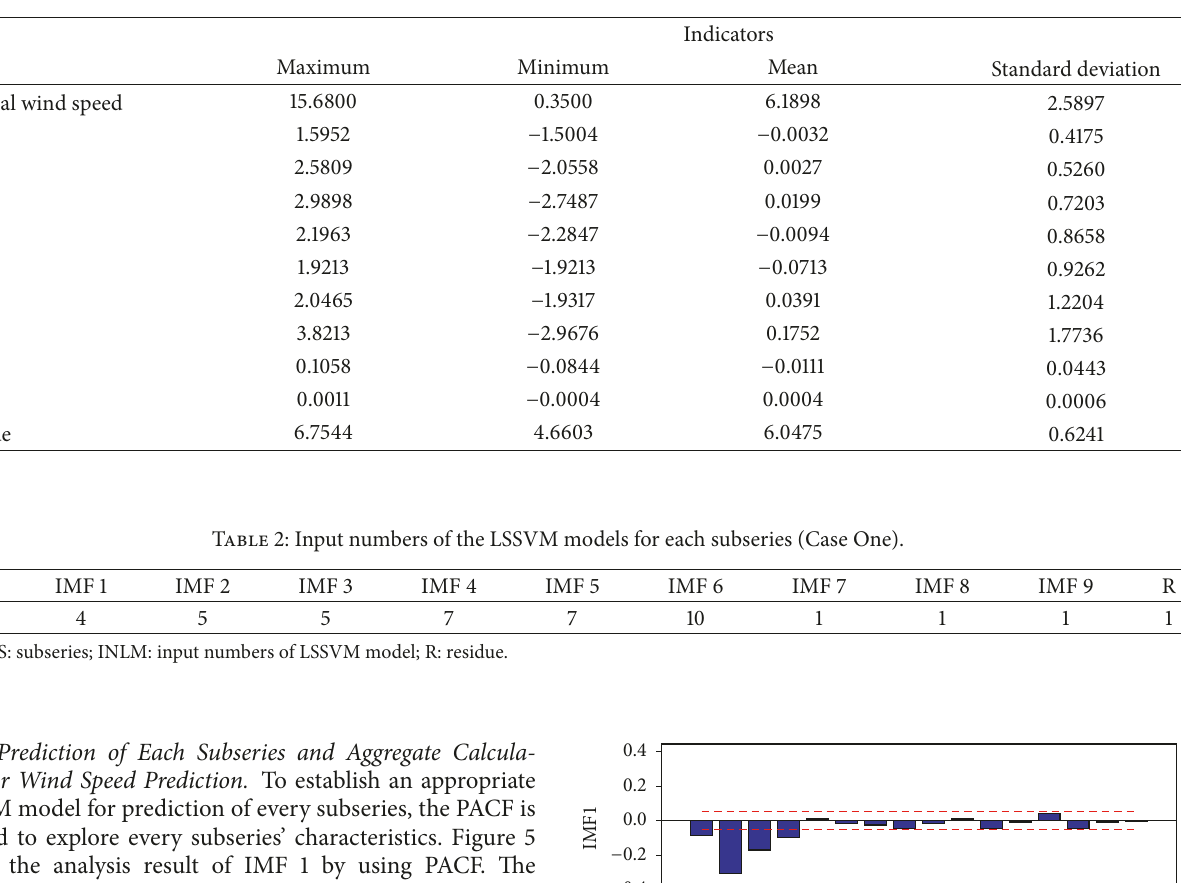
Table 1: Stabilization comparisons among original wind speed series and subseries (Case One).